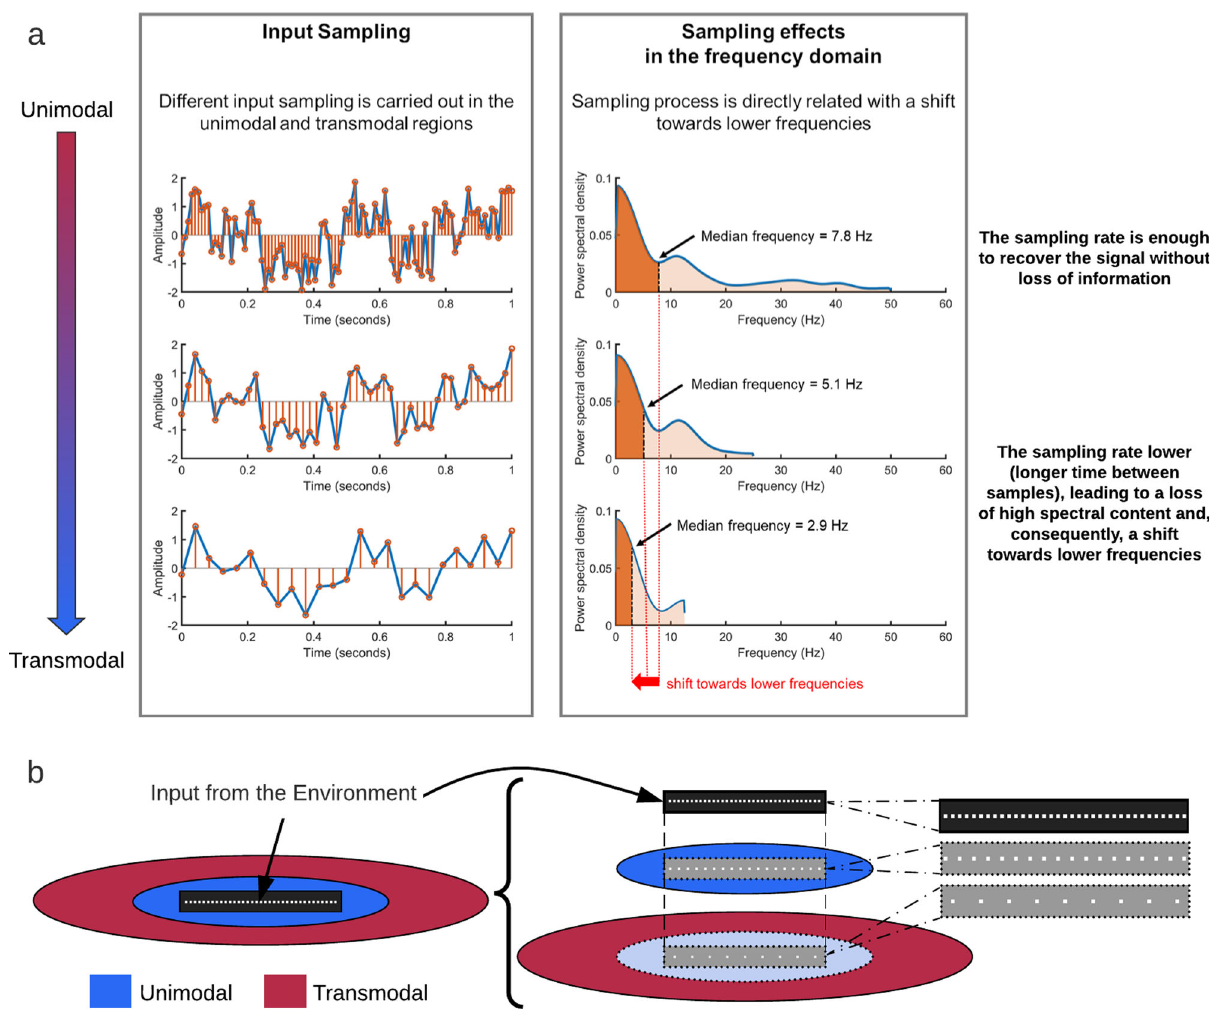
Fig. 7 Input sampling in the uni- and transmodal units. a The sub-sampling of a signal and shift in the frequency. The more the input signal is sampled, the more shift toward slower frequencies (indexed by median frequency). The fi rst of the three plots shows the original signal with sampling frequency of 100 Hz in time (left) and frequency (right) domains. The second row shows the same signal after sub-sampled, that is, the new sampling frequency is 50 Hz. The spectral component of this signal is shifted toward slower frequency compared to the previous one. Third row shows the same signal, but after a new sub-sampling at 25 Hz. b The same concept as ( a ) in the brain ’ s uni- and transmodal regions. The input is processed by both unimodal and transmodal regions, each time passing from a sampling machine, thus shifting toward slower frequencies (slow